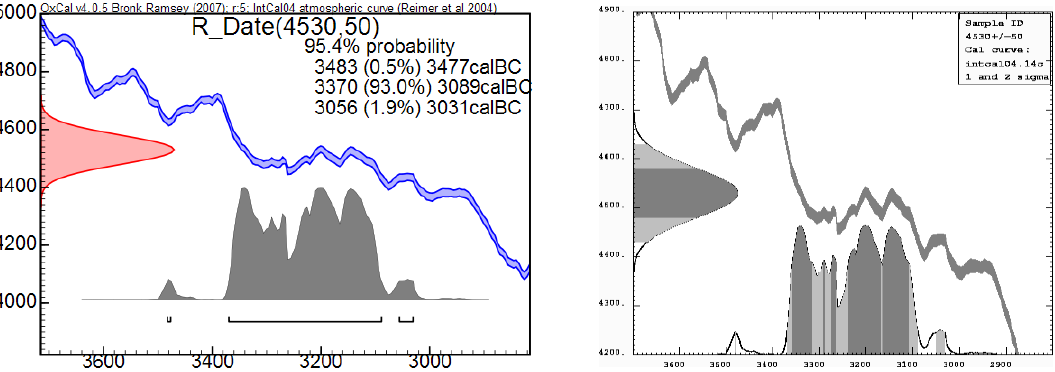
Fig. 3. Calibration graph of 4530 ± 50 14 C BP (via the IntCal04 calibration curve; Reimer et al., 2004), using OxCal 4.0 (left) and Calib 5.0 (right). The two programs give essentially the same result.